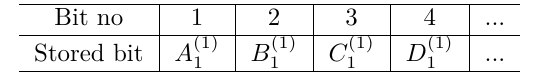
Table 3: Block-wise bit-only-slicing:the first share